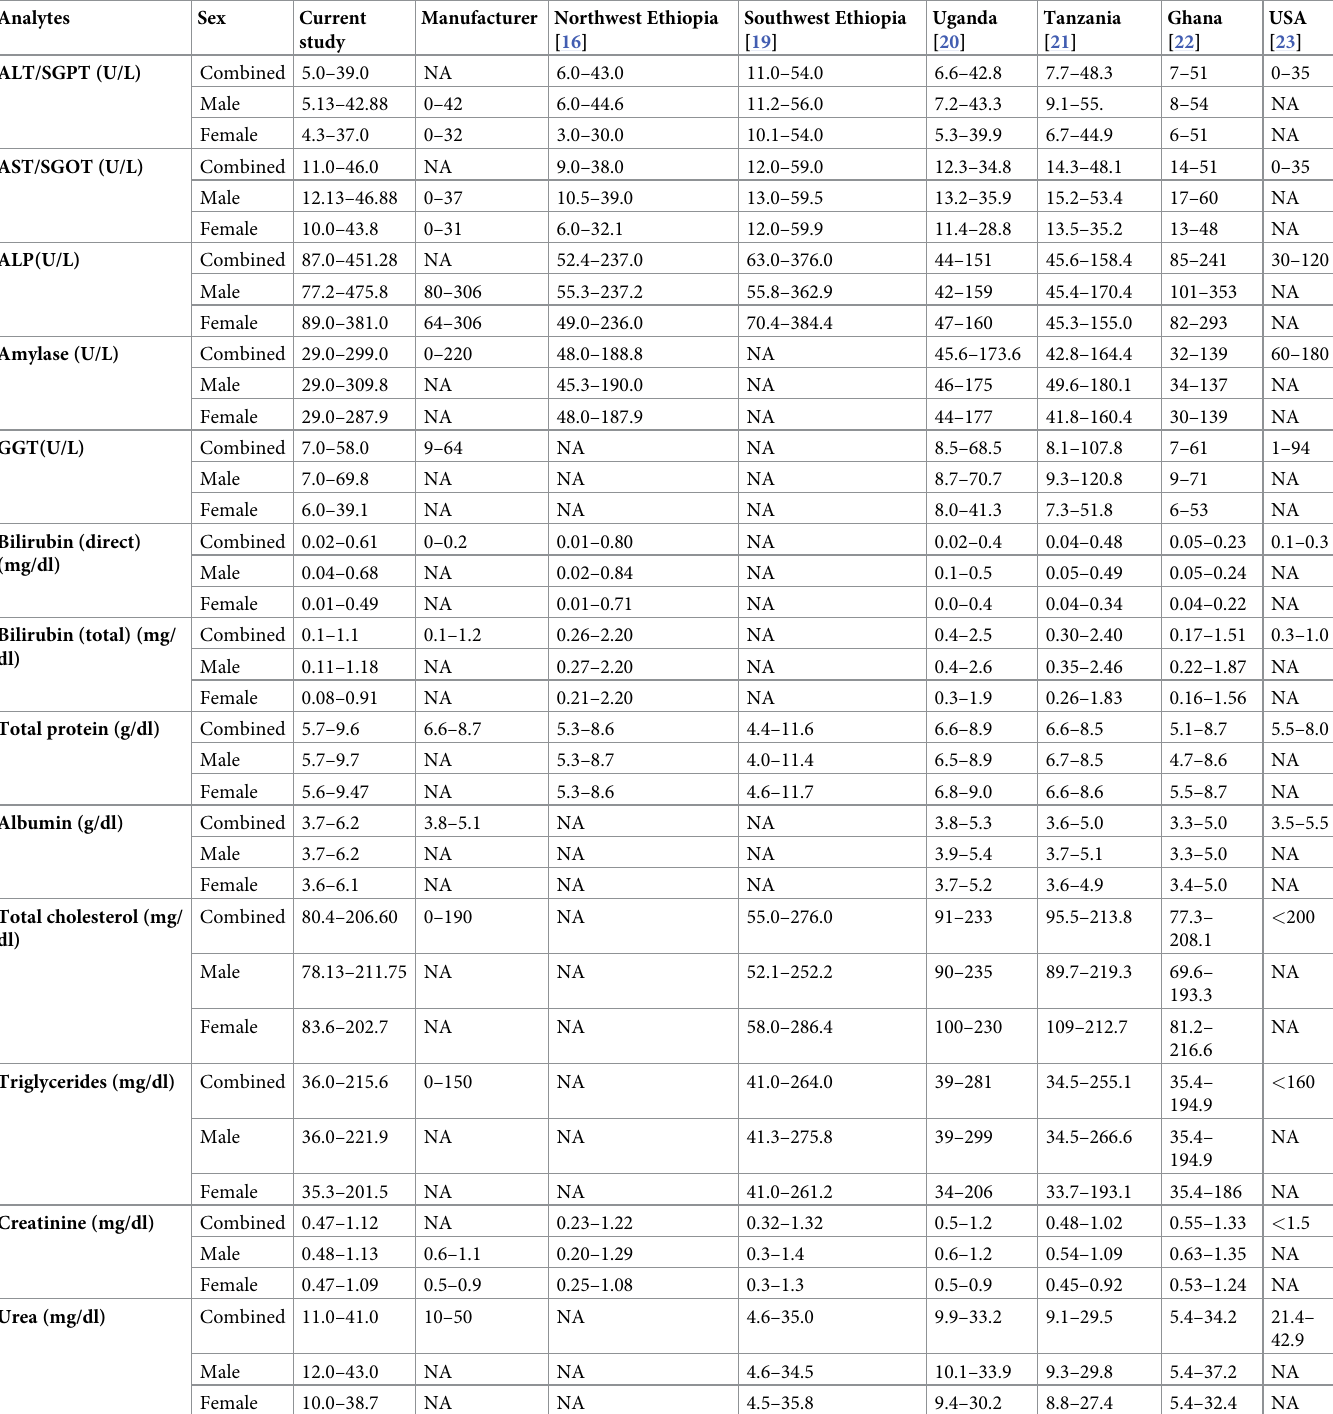
Table 4. Comparison of clinical chemistry parameter RIs of this study against manufacturer ranges and other similar